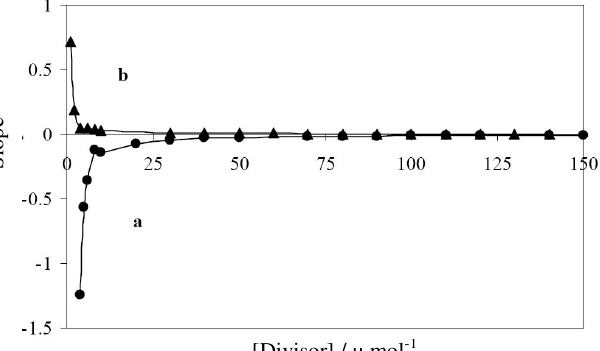
Figure 5. The effect of divisor concentration on the slopes of calibration curves for naphazoline and antazoline. Curve (a) naphazoline, divisor ANT at 227.2 nm and curve (b) antazoline, divisor NAP at 235 nm ∆λ